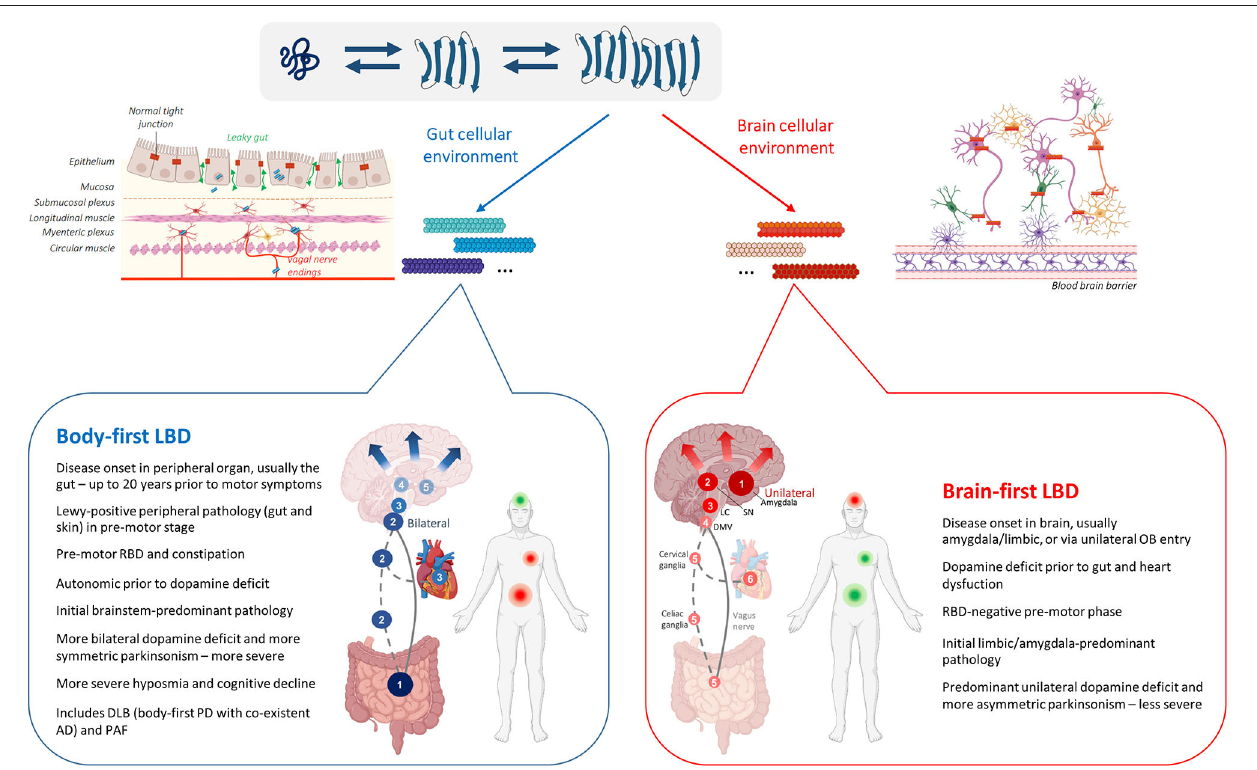
FIGURE 1 | Asyn strain variability in the LBD asyn origin and connectome (SOC) model. Upper panel : Schematic representation of the strain hypothesis in LBD as described by the SOC model. Physiological unfolded monomeric protein can misfold into pathogenic β -sheet-rich subunit conformations that are capable of seeding other pathogenic subunit conformers or monomers, ultimately elongating into mature fibrillary asyn. Monomeric asyn can adopt various β -sheet-rich conformations depending on the cellular milieu where the misfolding occurs. Therefore, distinct fibrillary asyn conformers or ’strains’, composed of different subunits, can arise depending on the cellular environment, determined by the neuron-type and its location (body or brain). Each distinct asyn strain may affect different parts of the brain and autonomic connectome in varying degrees, contributing to the heterogenous clinical representation of body-first and brain-first LBDs. Lower panel : Schematic representation of two LBD-subtypes as predicted by the SOC model. Numbers indicate progression of pathology from initiation (1) to more advanced disease stages (4–6). In body-first LBD, asyn arises in the ANS (usually the gut) from where it spreads bilaterally via overlapping vagal (full line) and sympathetic (dashed line) connections to the brain and to other peripheral organs causing autonomic dysfunction prior to dopaminergic deficit. Bilateral invasion of pathology in the DMV causes subsequent bilateral involvement of the LC causing RBD, and bilateral nigrostriatal neurodegeneration with symmetric parkinsonism as disease further progresses. In brain-first LBD, asyn arises unilaterally in the amygdala or olfactory bulb, after which it spreads to the unilateral SN causing unilateral neurodegeneration and asymmetric parkinsonism. Upon further progression to the LC, RBD may occur post motor deficit. Inevitably, pathology spreads to peripheral organs, causing autonomic dysfunction at advanced disease stages. Due to the low level of homotypic connections in the brain, initial predominant unilateral pathology and associated neurodegeneration is initially confined to a single hemisphere for some time in brain-first synucleinopathy. In contrast, bilateral invasion of pathology in the brain of body-first cases causes a more severe disease progression, including more severe hyposmia and cognitive decline. Body-first and brain-first LBD mainly predict disease progression in PD patients with and without pre-motor RBD. Furthermore, most DLB and all PAF patients can be categorized as having body-first LBD. Although cellular vulnerability and the presence of concomitant AD pathology may influence the spatial distribution of pathology and clinical profile in these LBDs compared to typical body-first PD. Abbreviations: SN, substantia nigra; LC, locus coeruleus; DMV, dorsal motor nucleus of the vagus; RBD, REM-sleep behavior disorder; DLB,dementia with Lewy bodies (LBs); PAF, pure autonomic failure (Created with